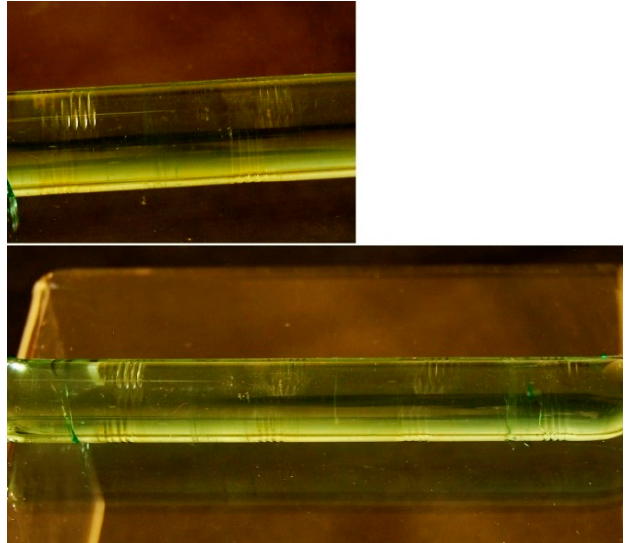
Figure 6. A section of a lease-rod (found in 2018).